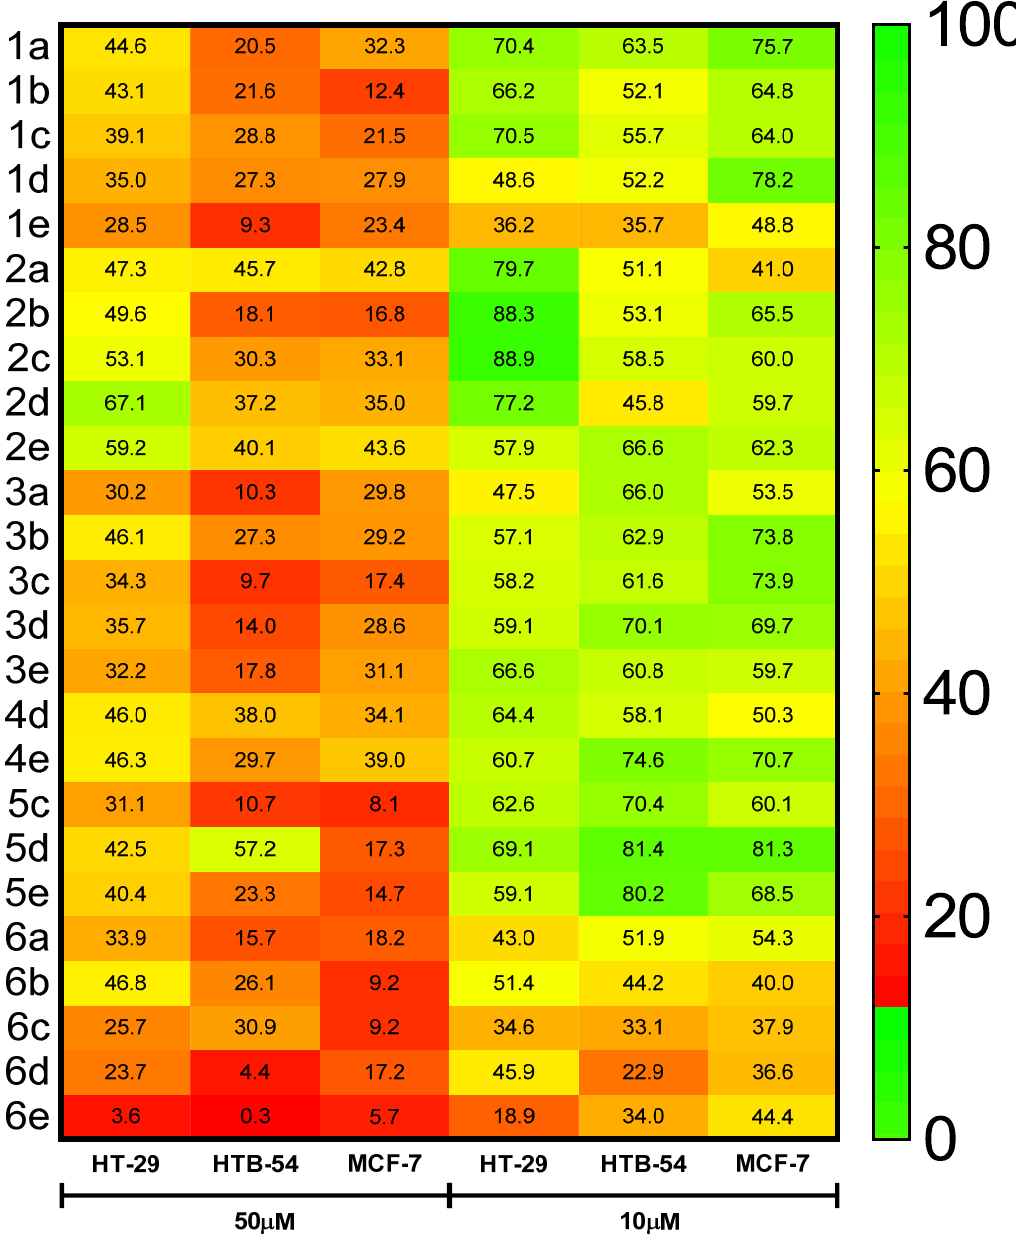
Figure 4. Heat map representation of cell viability, expressed as the percentage of live cells, after 48 h of treatment with each selenourea at 50 µ M and 10 µ M concentrations in HT-29, HTB-54, and MCF-7 cell lines. Red tones account for low cell survival; green tones account for great cell survival. Selenoureas 4a , 4b , 4c , 5a , and 5b were excluded due to their rapid degradation.